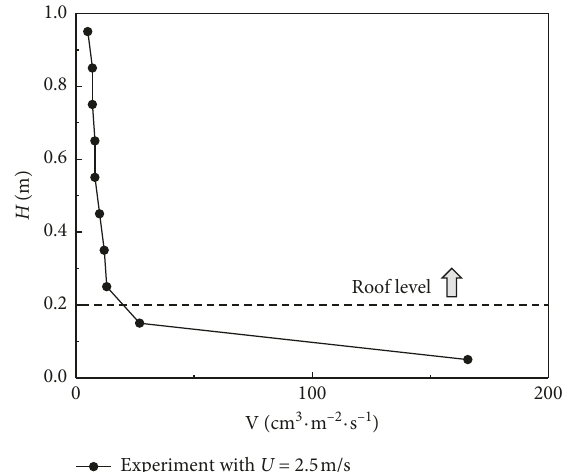
Figure 8: Snow flux along the vertical direction.